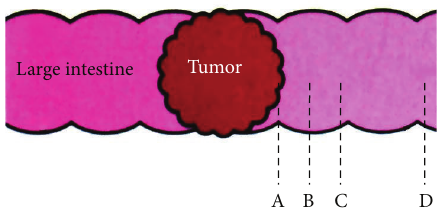
Figure 1: The schematic diagram of specimen of colorectal cancer removed and the samples obtained from four parts (Part A: tumor sample, Part B: intestinal mucosa sample 1cm away from the tumor, PartC:intestinalmucosasample2 cmawayfromthetumor,andPart D: intestinal mucosa sample 5cm away from the tumor).